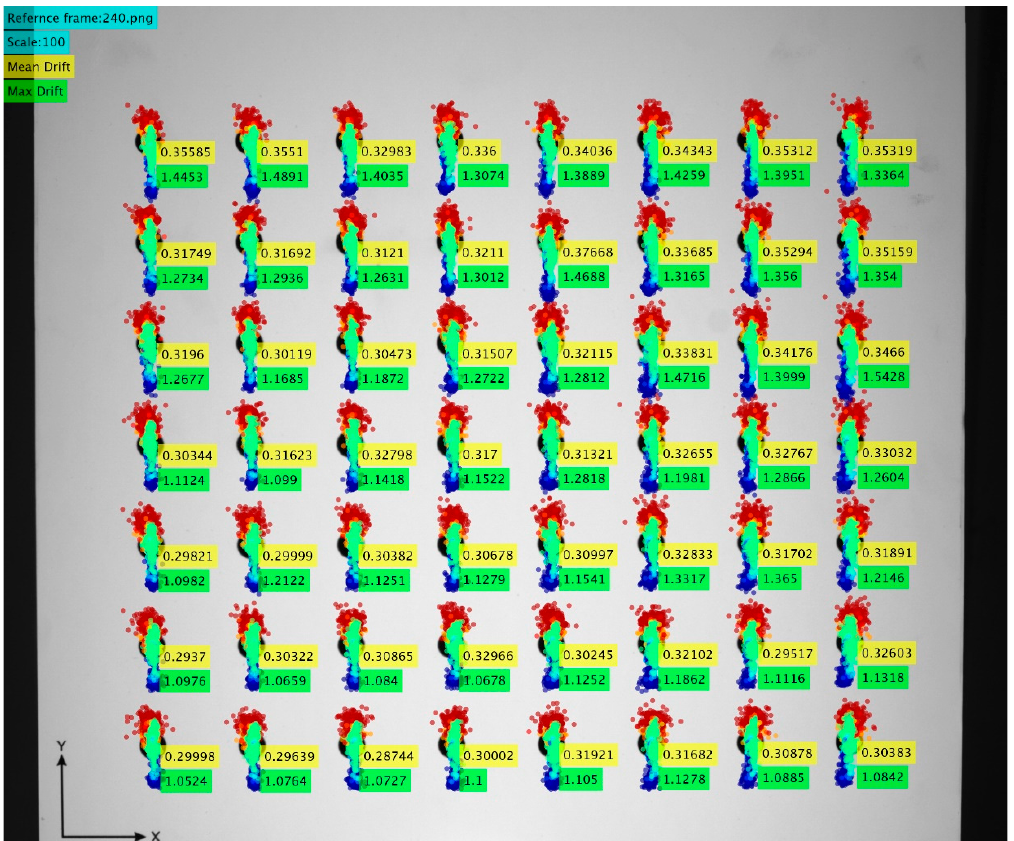
Figure 8. The registered thermal image drift recorded by the tested camera inside the thermal chamber during the parallel measurement with the stability observation. The mean and the maximum drift value for each marker are shown in pixel values. The drifts are scaled ×100 for better visualization. The color of the markers represents the temperature of the camera during the frame capture and is consistent with the temperature scale shown in Figure 7a.